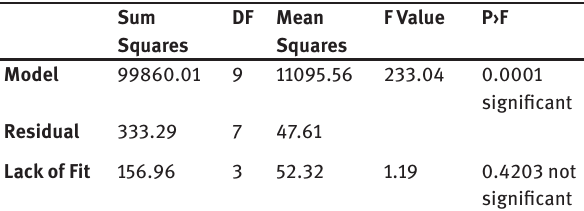
Table 3: Analysis of varience (ANOVA) for fitted quadratic polynomial model of polyphenol amount in black